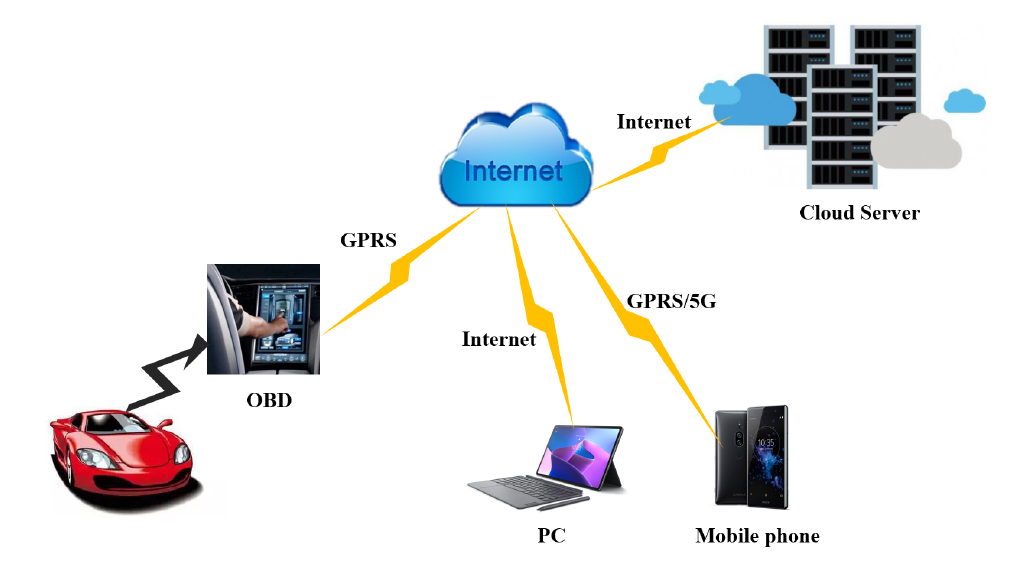
Figure 4. IoV system’s “End Management Cloud” three-layer